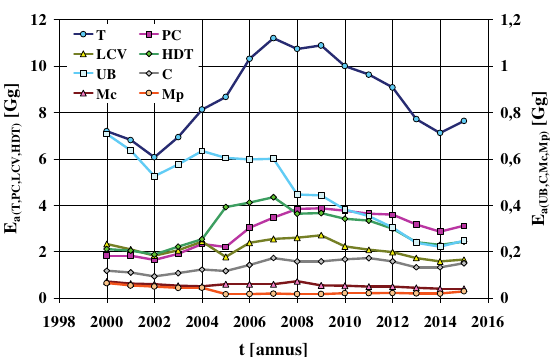
Fig. 16. National annual emission of particulate matter PM10 from tribological elements per cumulated vehicle category